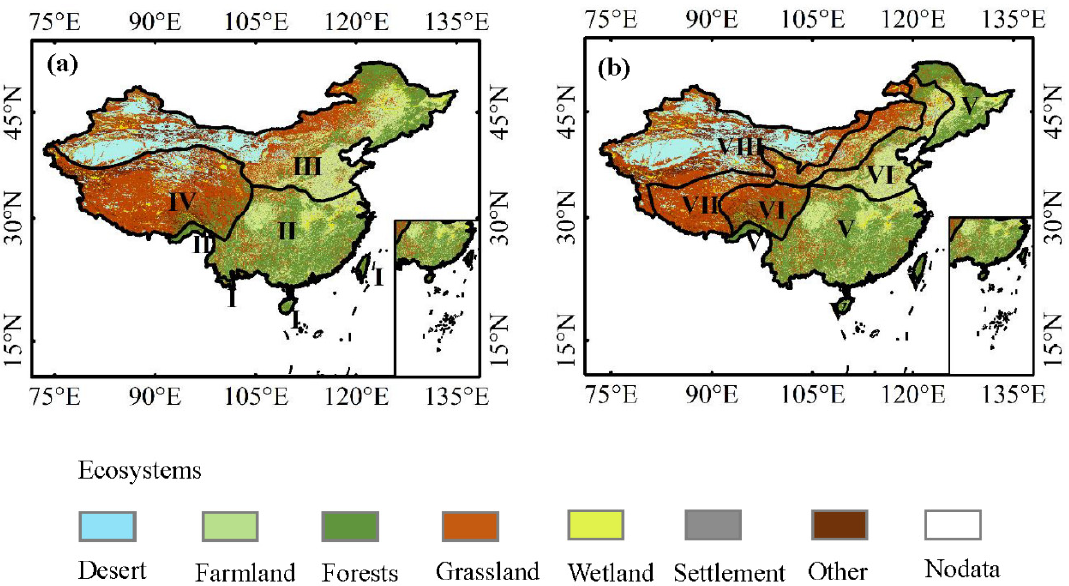
Figure 1. The physical geographic division of China. ( a ) Thermal regions. I, II, III, and IV are tropical regions, subtropical regions, temperate regions, and plateau climate regions, respectively; ( b ) moisture regions. V, VI, VII, and VIII are humid regions, semi-humid regions, semi-arid regions, and arid regions, respectively.